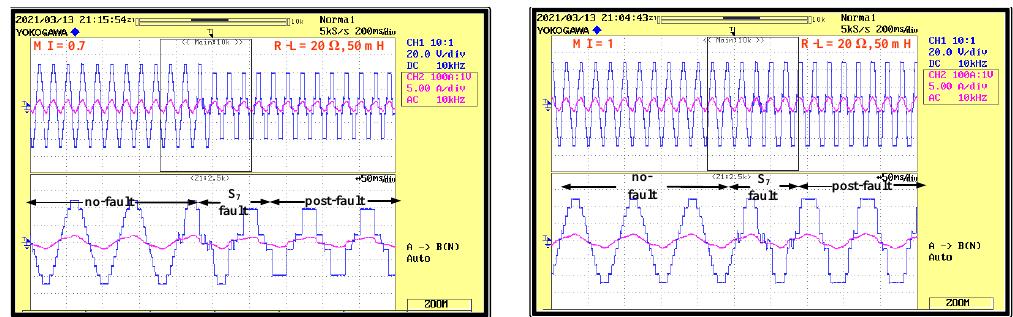
Figure 21. Experimental voltage and current waveforms under S 7 fault.